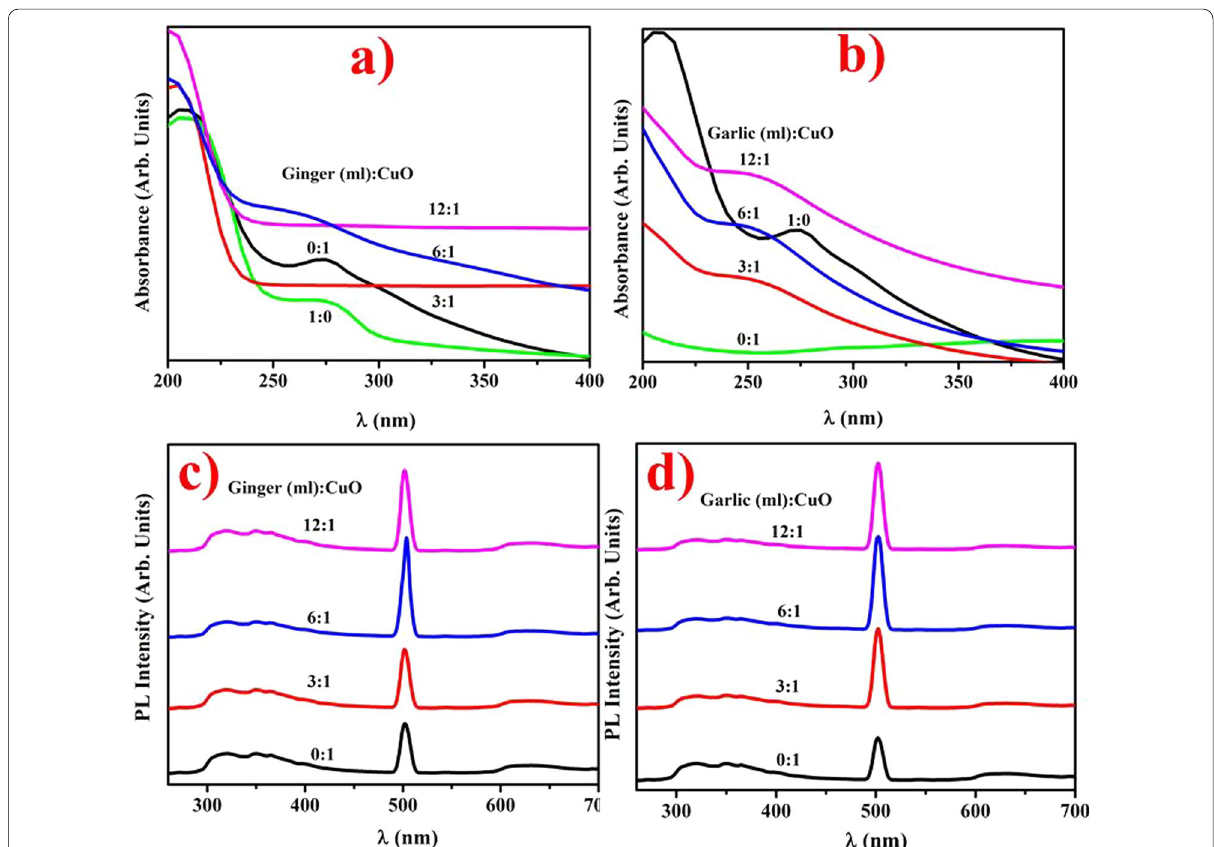
Fig. 2 Absorption spectra of CuO NPs doped with a ZO b AS extract and PL spectra CuO NPs with c ZO and d AS extracts,